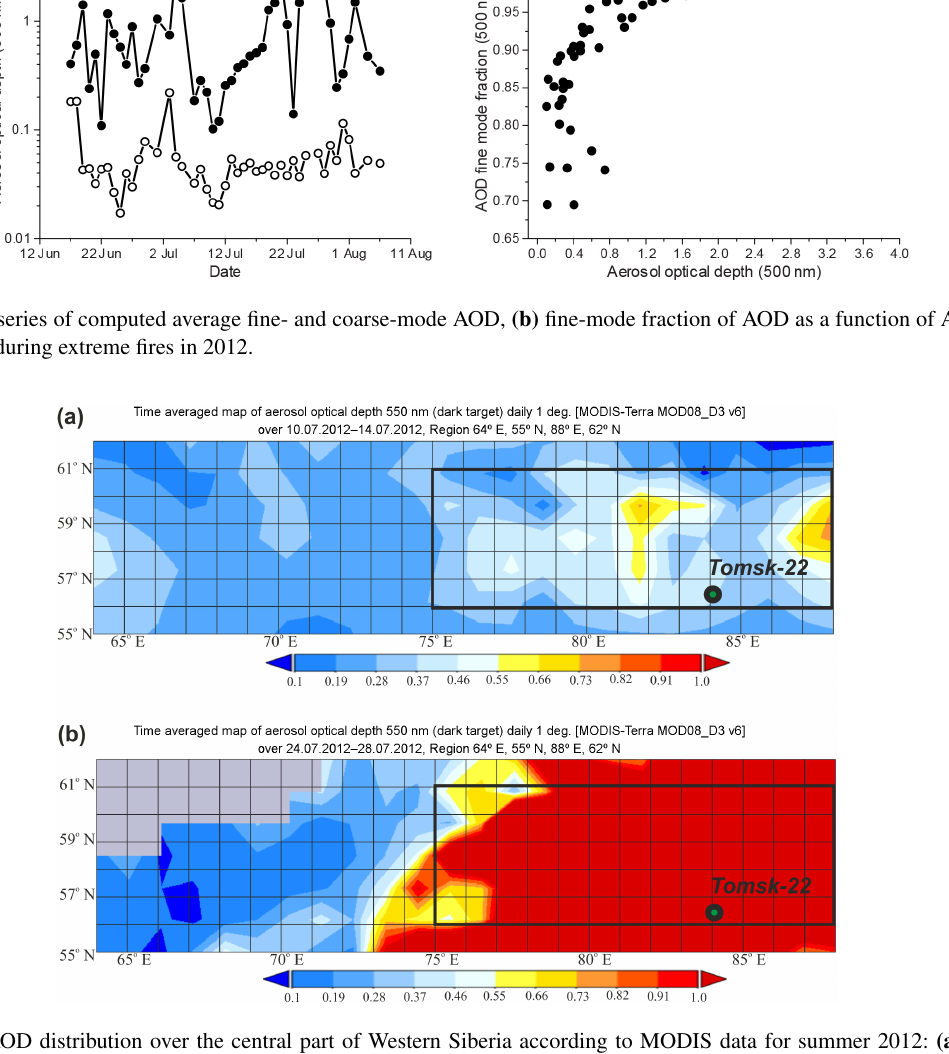
Figure 8. Spatial AOD distribution over the central part of Western Siberia according to MODIS data for summer 2012: (a) 10–14 July, (b) 24–28